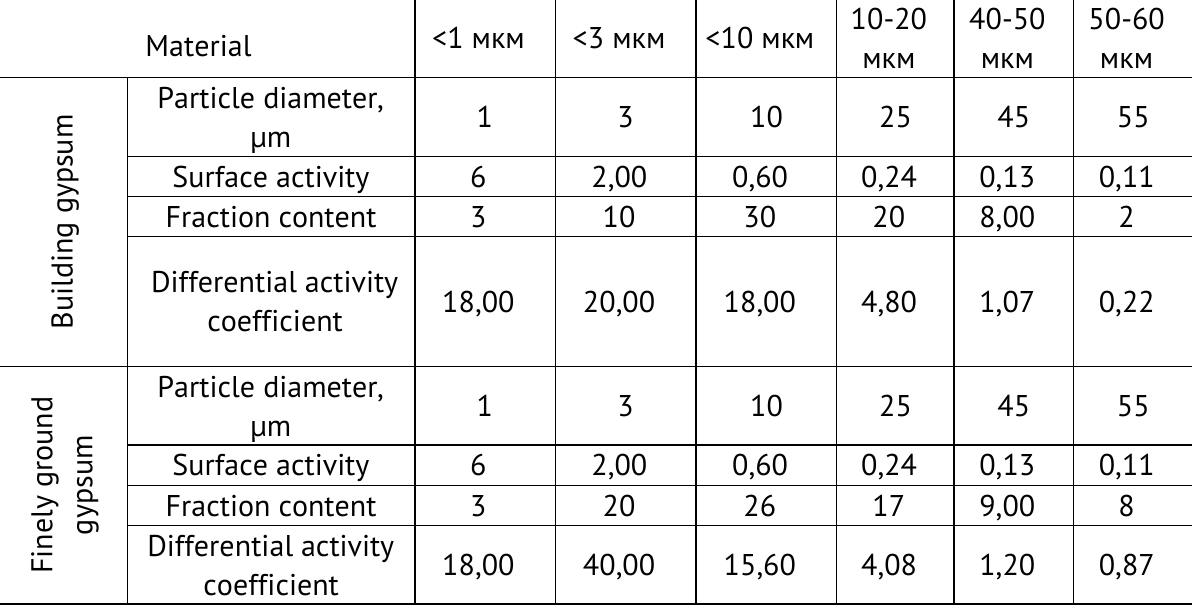
Table 2. Values of interphase region of building gypsum and finely ground